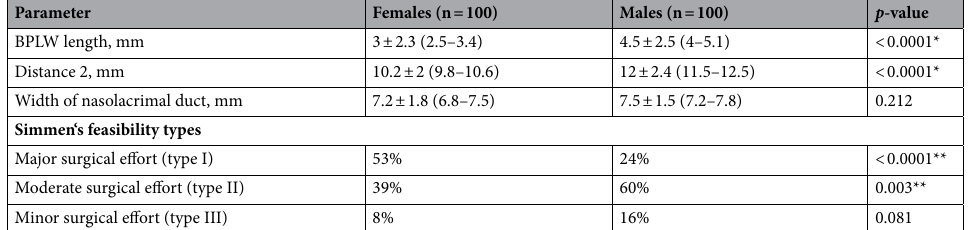
Table 1. Patient’s clinical characteristics according to gender groups. BPLW bony pre-lacrimal window. Continuous variables are presented as means ± standard deviations and 95% confidence interval (CI). Categorical variables are expressed as percentages. *Represents statistically significance at the 0.05 α-level. **Represents statistically significance at the Bonferroni adjusted significance level (α = 0.05/3 =